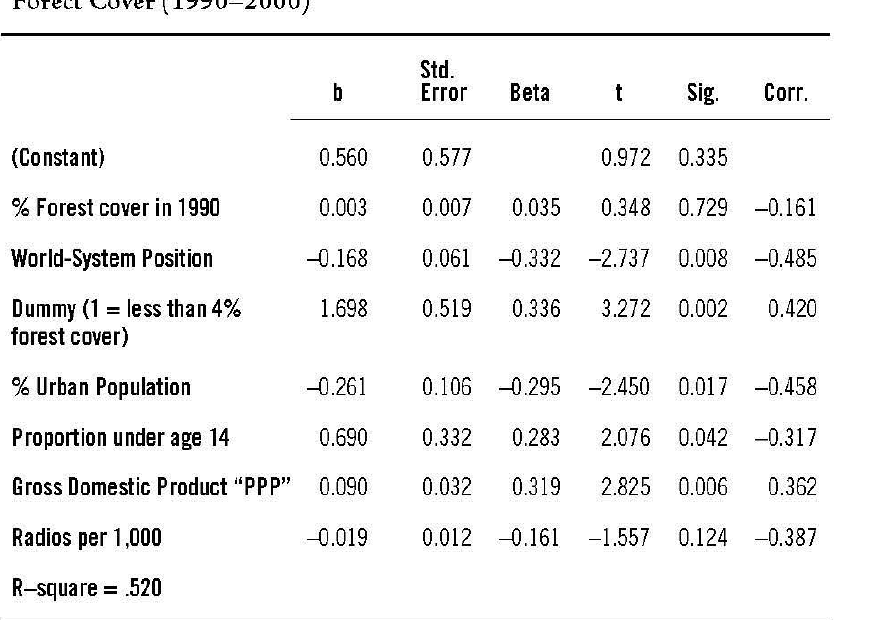
Table 1 - Main Effects Model for Average Annual Change in% Forect Cover